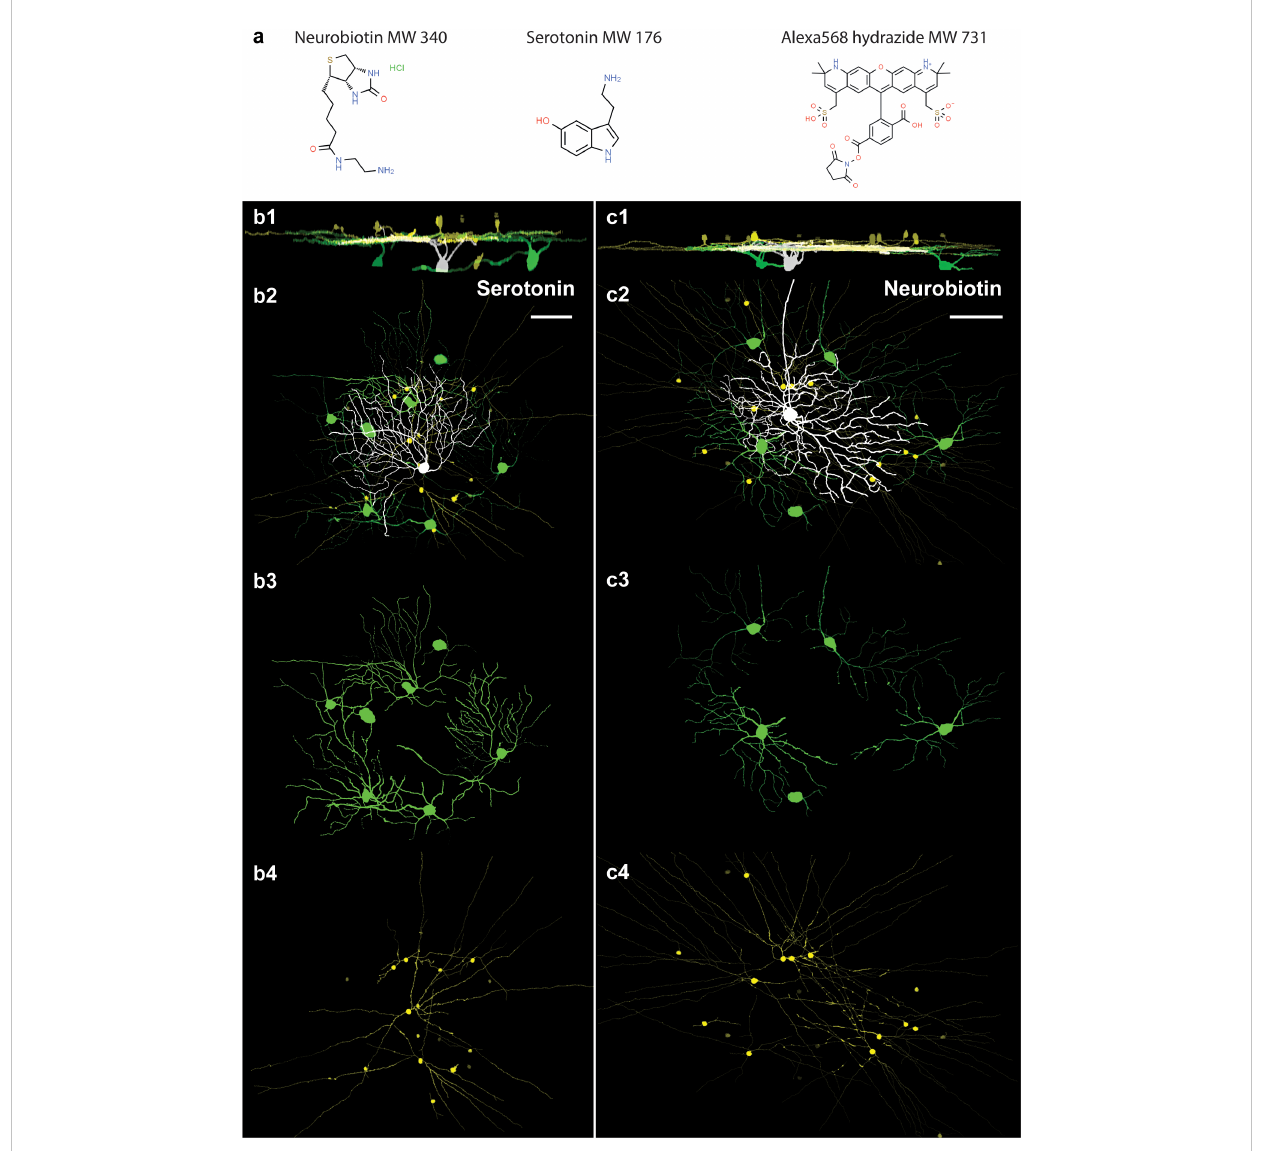
FIGURE 2 Comparison of serotonin and NB coupling of OFF alpha RGCs in the mouse retina. (A) . The chemical structures and molecular weights (MWs) of NB, serotonin, and Alexa568 compounds that were used in this study (Chemspider.com). (B) . 1 – 4. Side (1) and face (2 – 4) views of serotonin-injected OFF alpha RGCs (white). Serotonin-coupled nearby RGCs (green) display a dendritic strati fi cation level and morphology resembling the injected OFF alpha RGC. The somata and processes of serotonin-coupled ACs (yellow) display a wide- fi eld morphology. (C) . 1 – 4. Side (1) and face (2 – 4) views of NB-injected OFF alpha RGCs (white). Coupled nearby RGCs (green) display a dendritic strati fi cation level and morphology resembling the injected OFF alpha RGCs. In line with previous descriptions (11, 12), the somata and processes of NB-coupled ACs (yellow) display a wide- fi eld morphology. Scale bars: 50 m